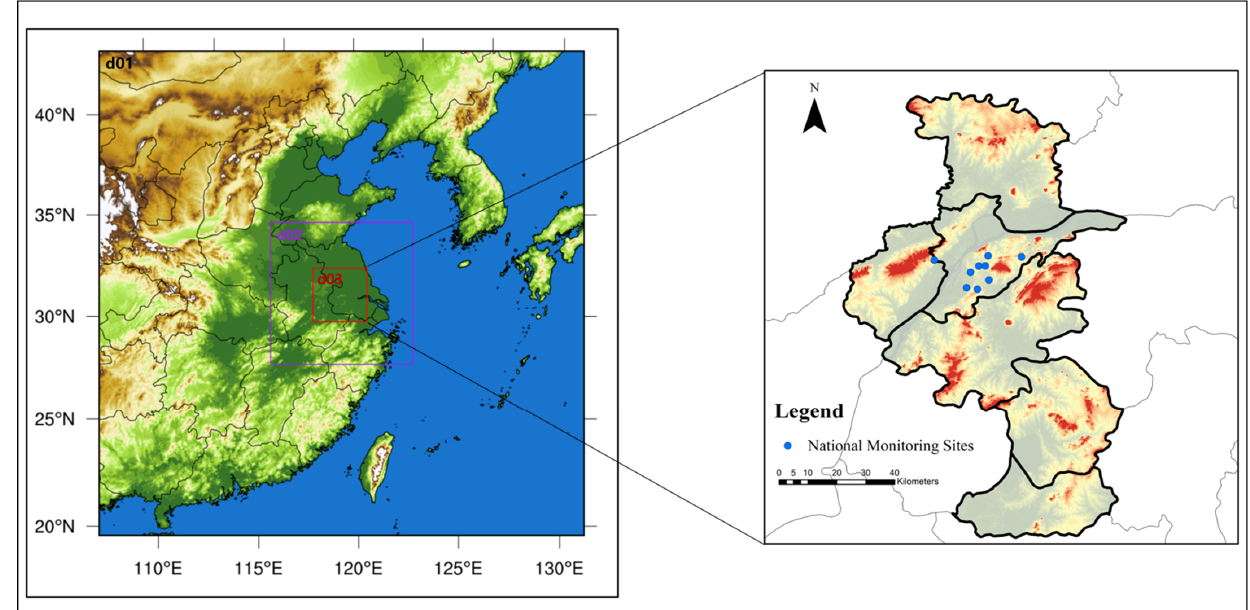
Figure 1. Scope of the model nested areathe three-nested domains consisting of the outer domain (d01), inner domain (d02), and innermost domain (d03) (horizontal resolutions of 27 km × 27 km, 9 km × 9 km, 3 km × 3 km, respectively) and the location of the national monitoring sites in